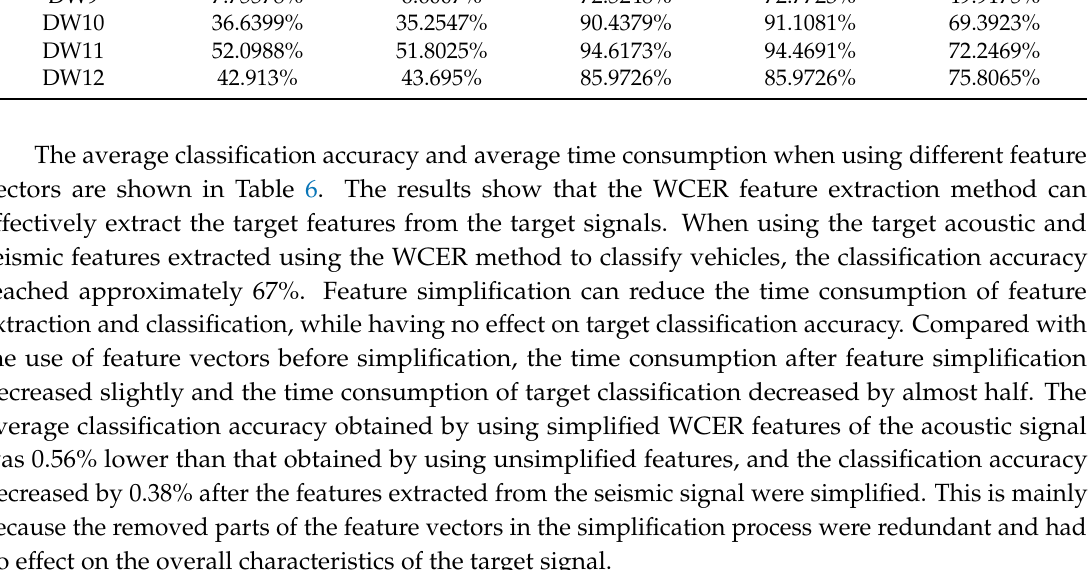
Table 6. Average classification accuracy and time consumption using different feature vectors.